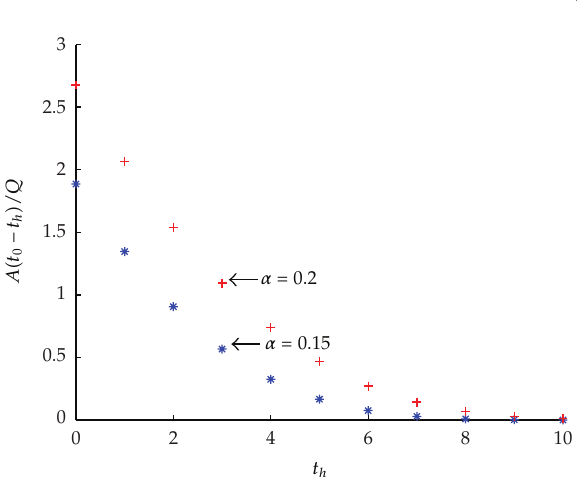
Figure 3: Influence of α on A (cid:6) x,t (cid:7) for the front of the platoon.